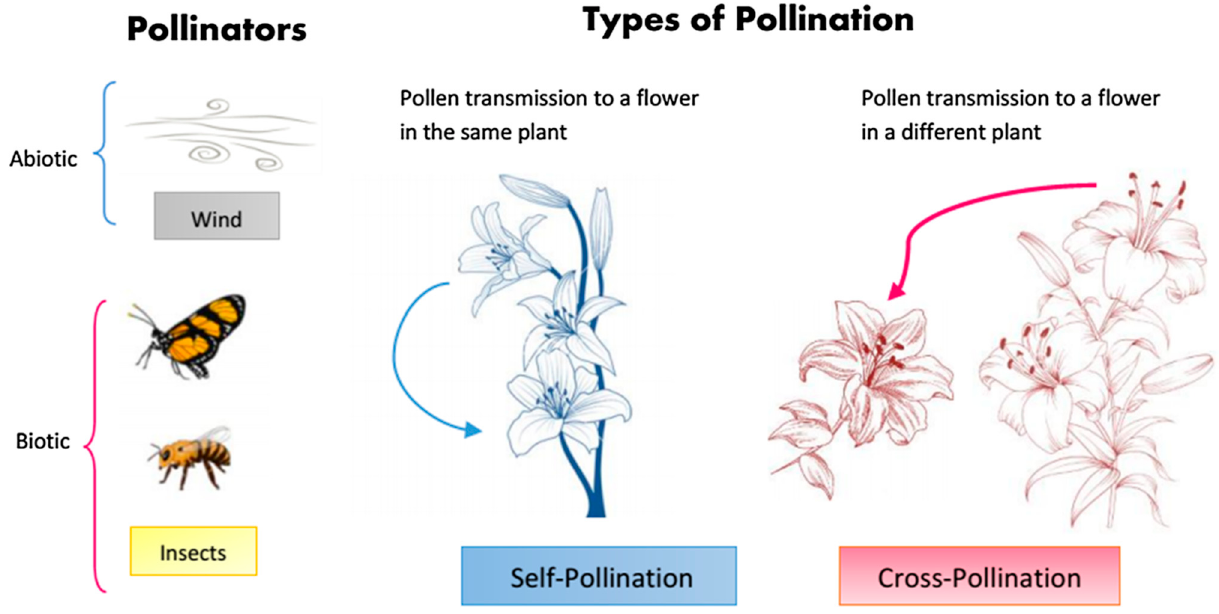
Figure 1. Pollination types and pollinators in the FPA [38].